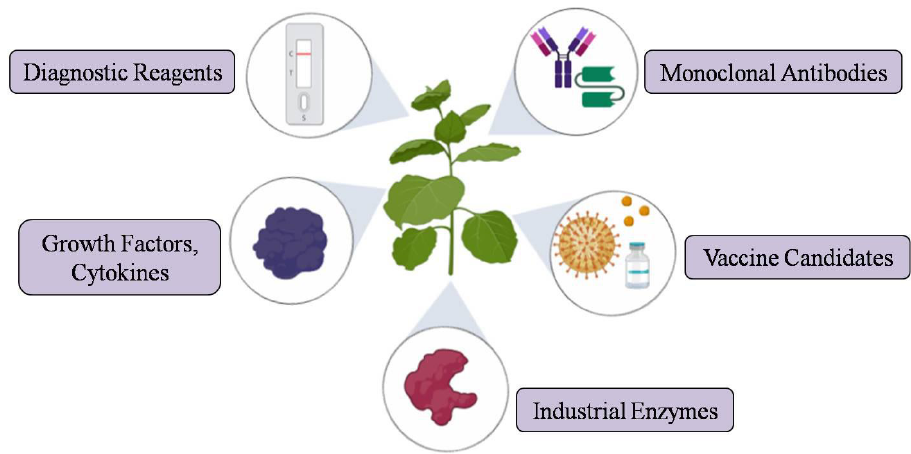
Figure 2. Schematic representation depicting the application of transient expression system for the production of various recombinant proteins.